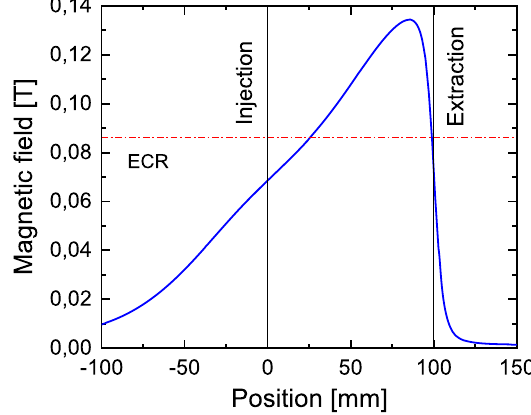
INFN-LNS.FIG. 1. PS-ESS magnetic field profile that was used during the measurements.